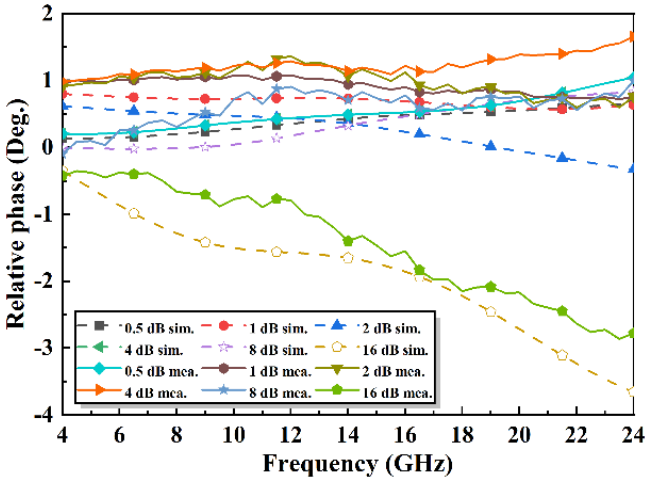
Figure 18. The simulated and measured relative phase variations for the major states.